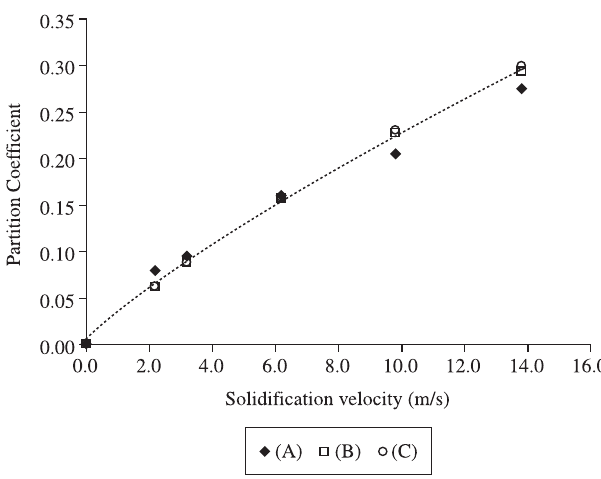
Figure 9. The effect of solidification velocity on Bi partition coefficient in Si-Bi alloy: A) experimental 10 ; B) equation 2, 4 and 5 using K and C) Fitting of Sobolev’s model to the experimental